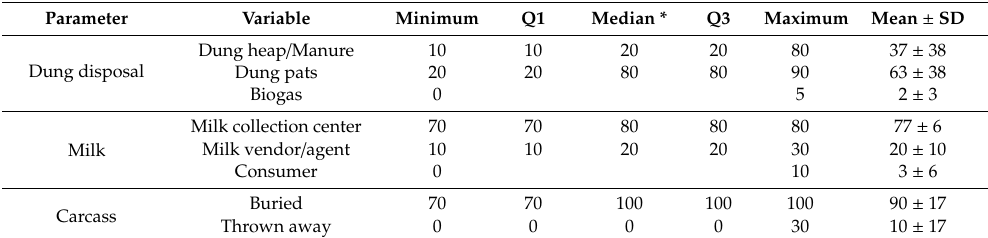
The proportions (%) of output value chains components—dung, milk and carcass disposal—based on FGDs conducted in Punjab, India during 2018–2019. Parameter